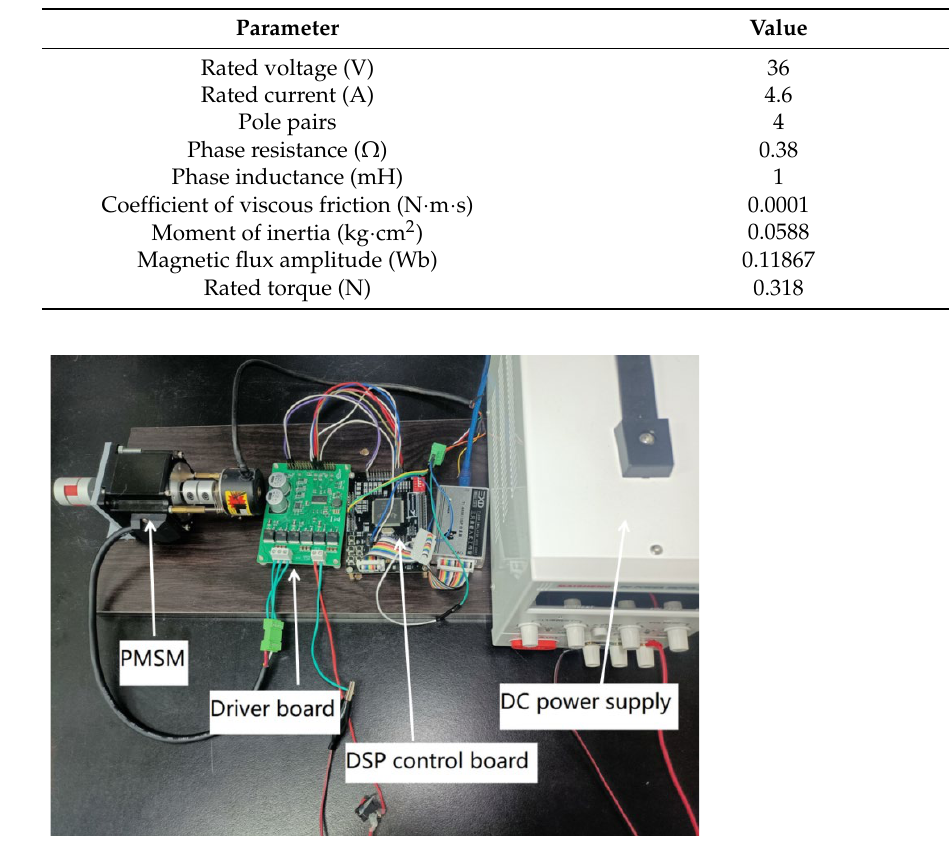
Figure 10. Speed response curve when α = 0.01. 0